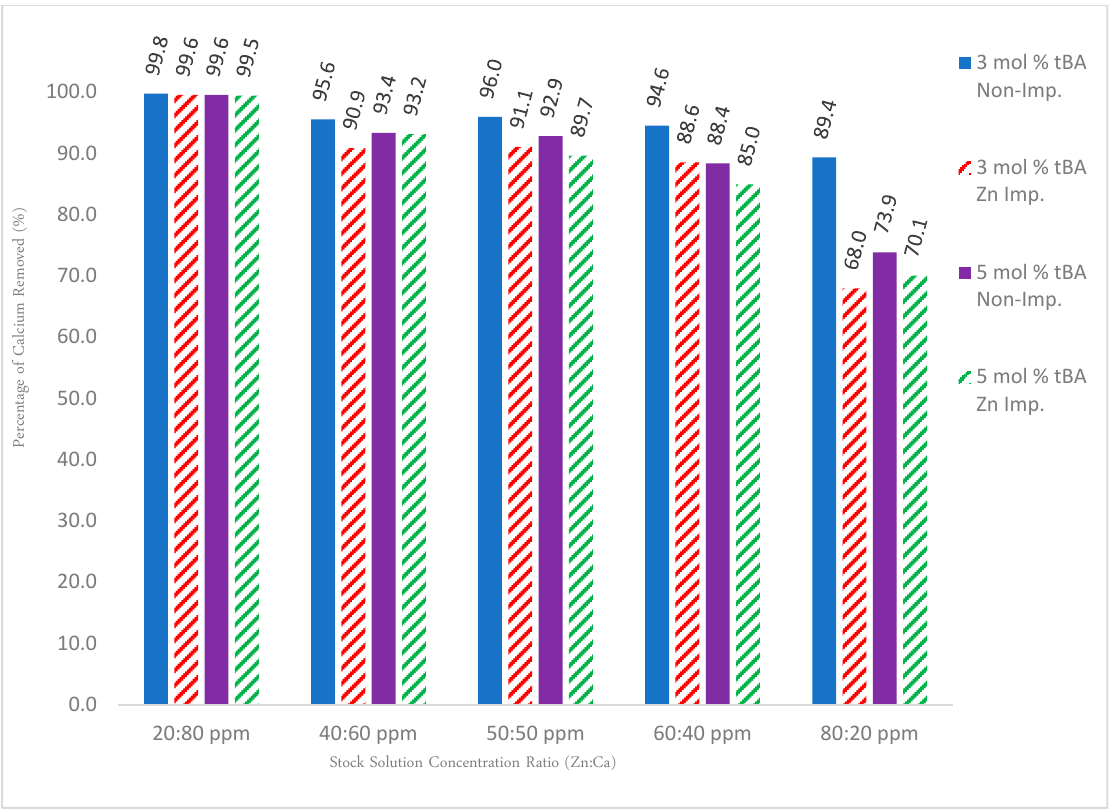
Figure 13. Complementary data set to Figure 12. All calcium values were obtained from the same binary ion experiments used for Figure 12. All polymers contain 5 mol % EGDA crosslinker.